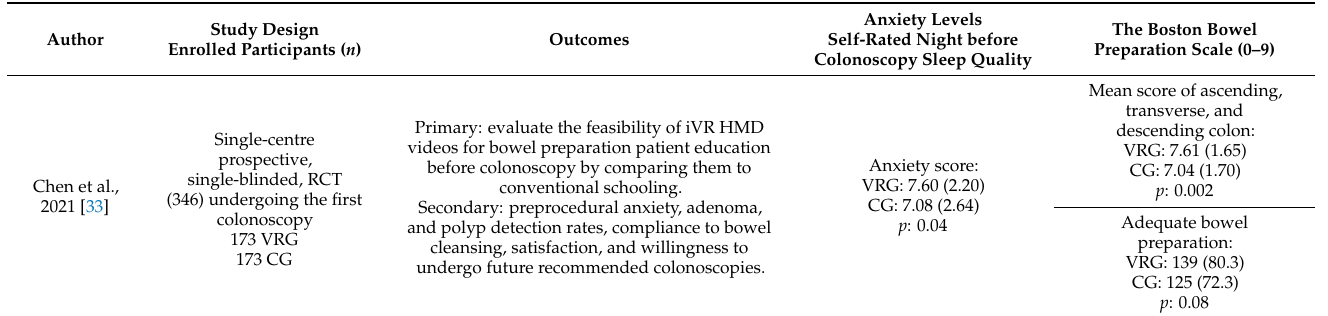
Table 3. iVR RCT education for bowel preparation impacts patient anxiety levels and preparation